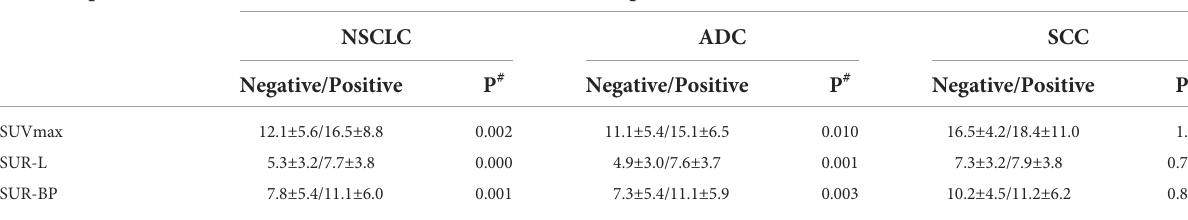
TABLE 2 The relationship between PET parameters and PD-L1 expression. PD-L1 expression